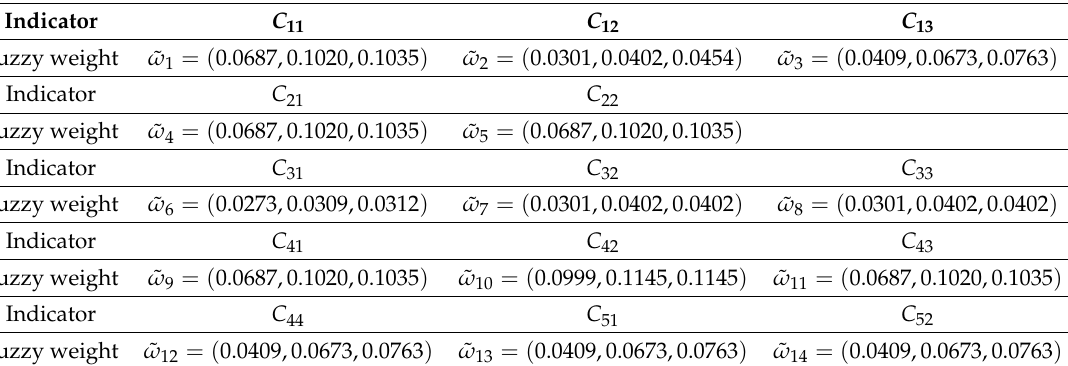
Table 5. Fuzzy weight of each indicator.